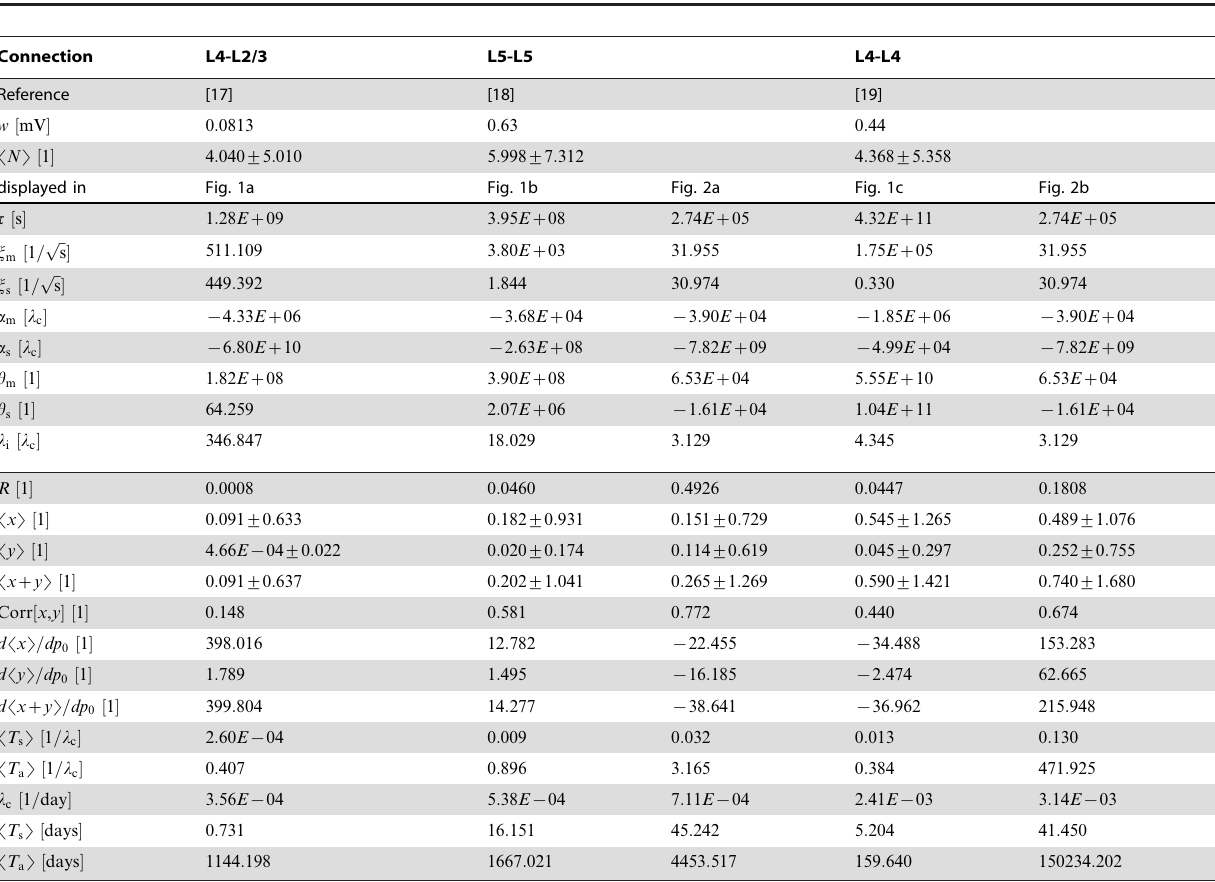
Table 1. Reference data, optimized parameter sets and properties of the structural plasticity models.